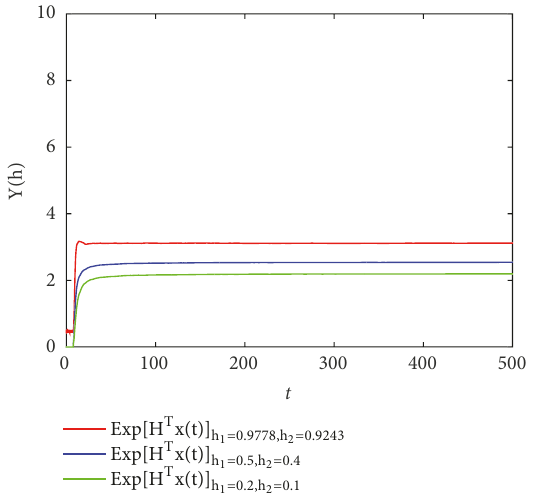
Figure 5: The optimal harvesting effort and the maximum of ESY [45]. Red line is with ℎ 1 = 0.9778, ℎ 2 = 0.9243 , blue line is with ℎ = 0.5, ℎ = 0.4 , and green line is with ℎ 1 2